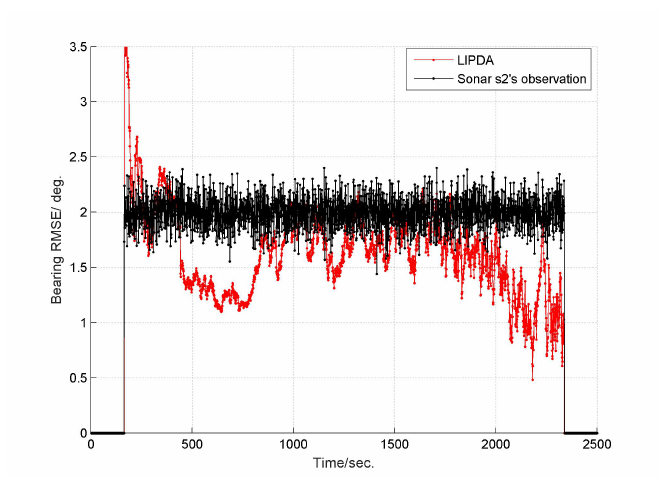
Figure 6. RMSE of estimated target bearing and the raw bearing observed by sonar s 2 at case